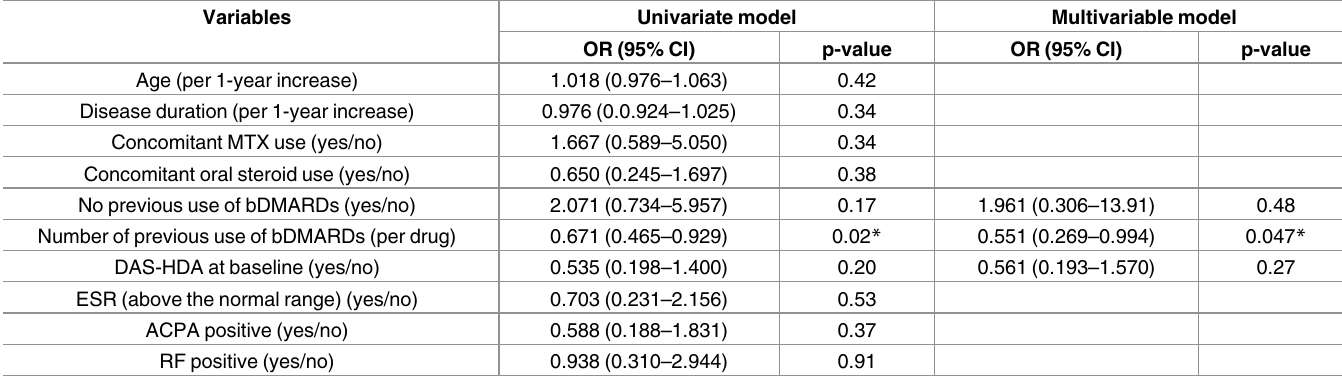
Table 4. Multivariate regression model to estimatethe factors associated the achievement of LDA at 24